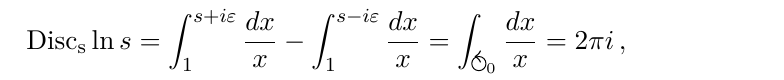
Figure 2 . The logarithm can be defined as an integral along a path ln γ s = R paths begin at x = 1 and end at x = s . The value of ln γ s depends on the number of times the integration contour wraps around the branch point at the origin. We define families of paths by γ n where n denotes the number of times the path circles the origin. The family labelled γ 0 is defined to give the principal branch of the logarithm. On the negative real s axis ln γ ln γ s = ln( s − iε ) − 1